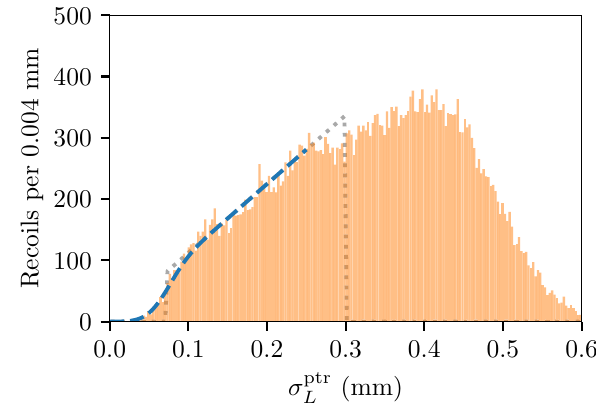
Fig. 17 A histogram of σ ptr (solid orange bars) from the beam-on L dataset with E > 100 keV and 75 ◦ < θ < 105 ◦ , with a fit to the lead- ing edge (dashed blue line) using Eq. (25) convolved with a Gaussian smearing function. The dotted gray line shows the fitted function